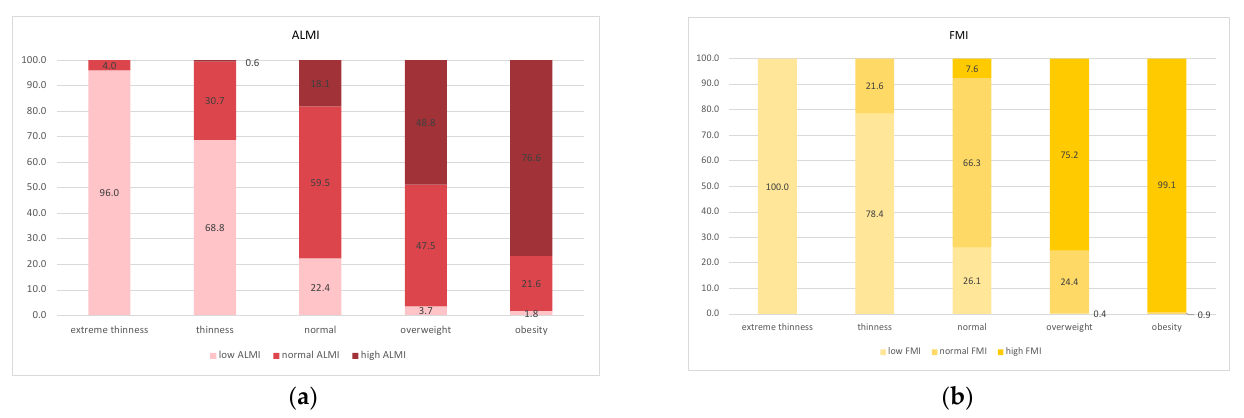
Figure 1. Prevalence of body compartments in BMI categories